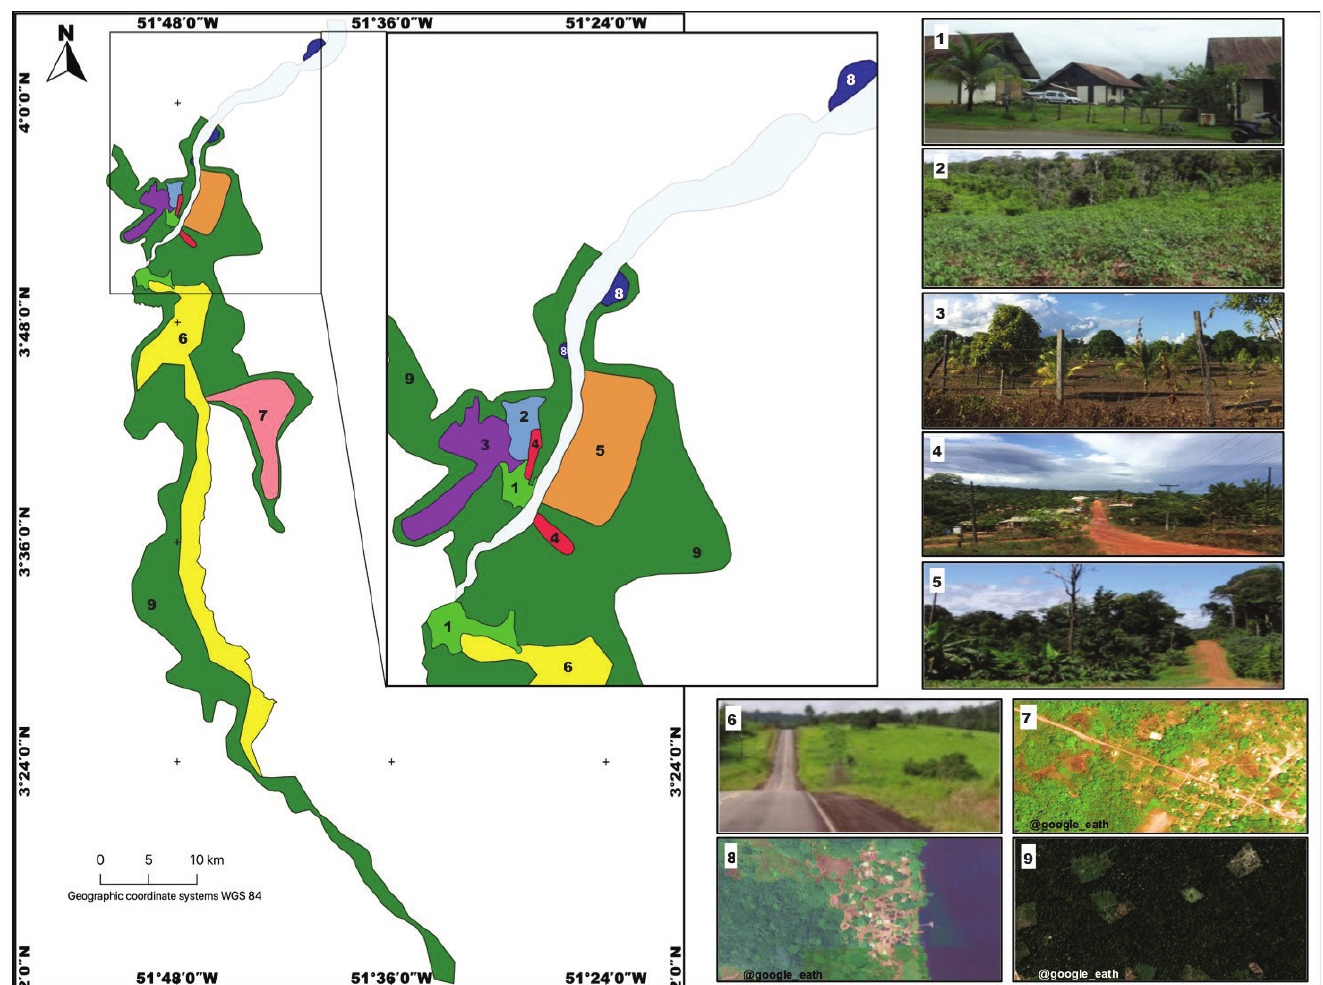
Figure 4: Types of landscape in the study